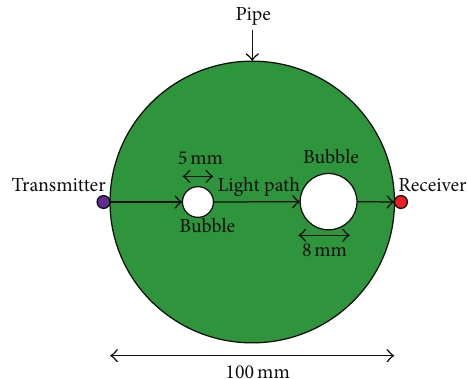
Figure 3: The light path when double model is present in contami- nated